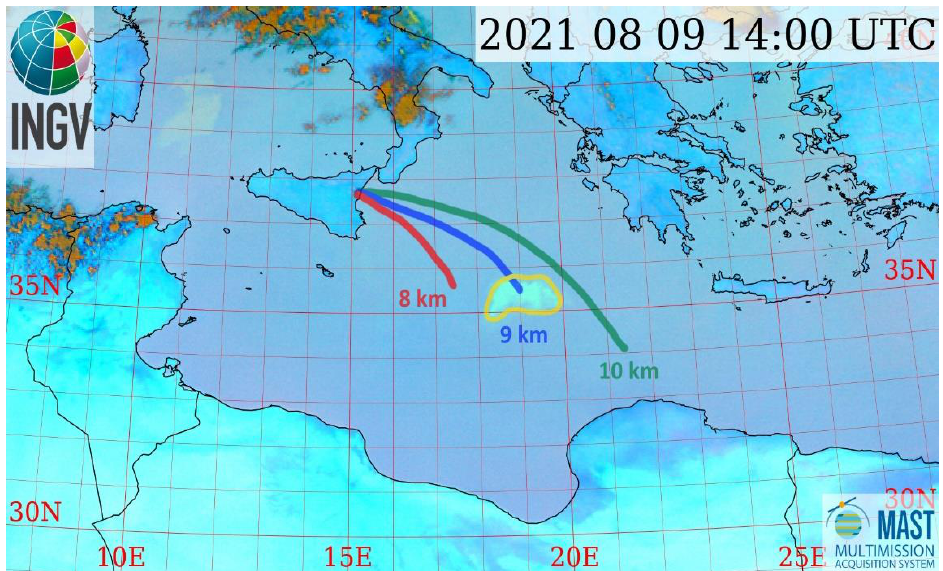
Figure 4. Example of VCTH computation using the HY procedure applied on the 9 August 2021 Etna lava fountain. SEVIRI image collected at 14:00 UTC, RGB composition (R: BT 12.0 −BT 10.8 ; G: BT 10.8 −BT 8.7 ; B: BT 10.8 ) with the volcanic cloud outlined in yellow. The output of the HYSPLIT model considering three forward trajectories at different altitudes (8, 9, and 10 km asl) is overlaid on the figure.